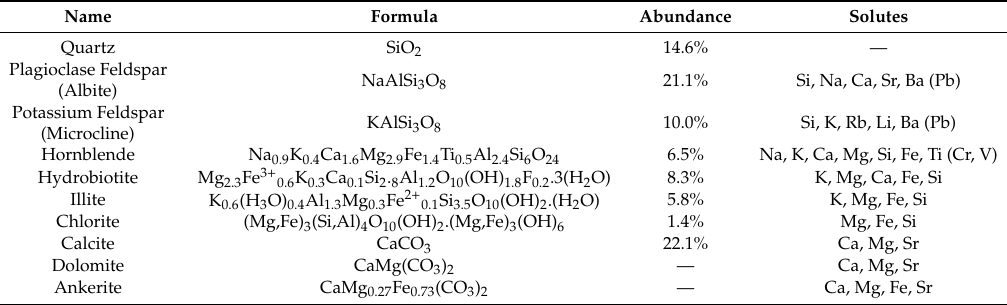
Table 3. Mineralogical compositions of sediments, mineral abundances, and estimated contribution to the chemical composition of the